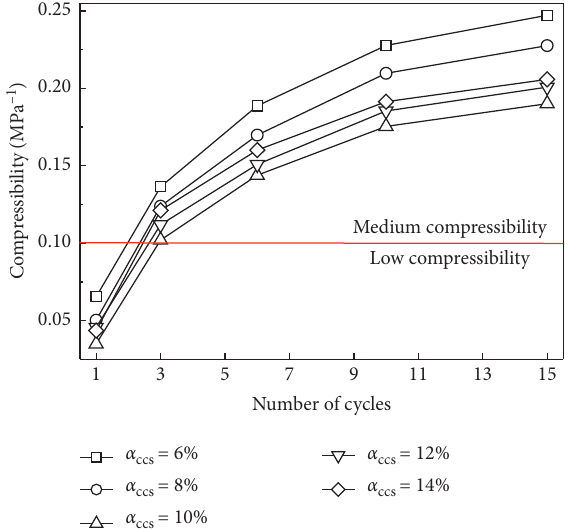
Figure 4: The variation of compressibility during the wetting- drying